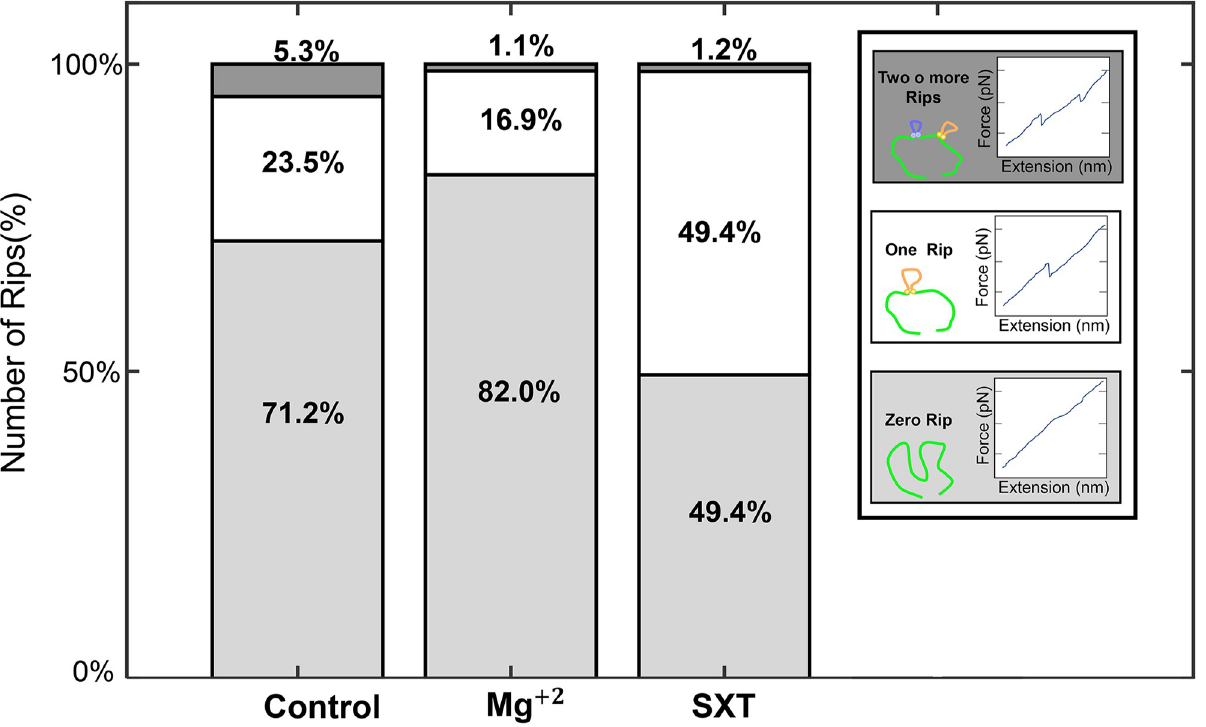
Fig 2. Abundance of rips in the APTSTX1 aptamer with Mg +2 and SXT. Number of rips observed in unfolding state under the different experimental conditions. Light grey represents the percentage for zero number of rips, white represent 1 rip in the force vs extension graph, ie, only one structure is unfolded as shown in the illustration and dark grey represents more than 1 rip, ie, two or more structure are unfolded as shown in the illustration. Total number of experiments considered were 132 for CNT, 77 for SXT, and, 178 for Mg +2 .